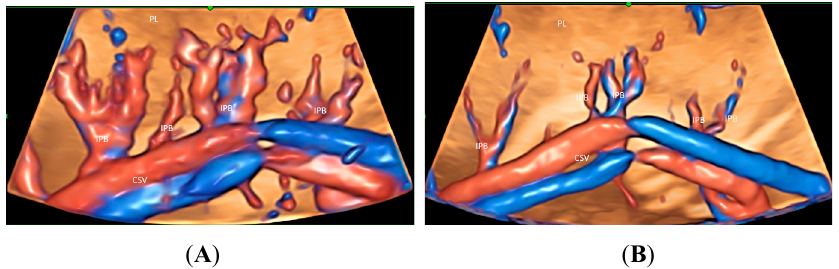
Figure 10. Three-dimensional volume acquisition in high-definition flow, displayed in glass-bode mode in a monochorionic twin pregnancy with selective growth restriction (FGR) at 27 weeks’ gestation. Note the difference in the intraplacental branches (IPB) of the umbilical artery between the twin fetus with normal growth ( A ) and that with FGR ( B ). Branches are infrequent in ( B ).